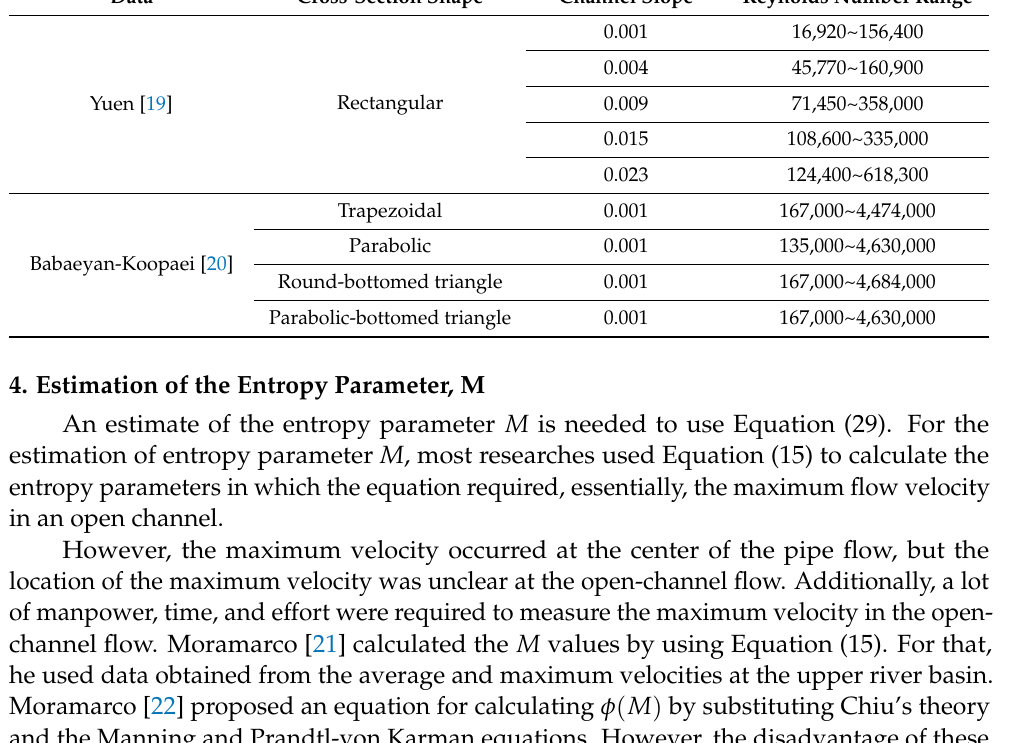
Figure 4. Relationship between (cid:1839) and (cid:1844)(cid:1857) calculated using Babaeyan-Koopaei’s data. 5. Results Analysis The entropy parameter M, defined in Section 4, was used in Equation (32) to calculate the coefficient of friction (cid:1858) in an open-channel flow. The relationship between (cid:1858) and (cid:1844)(cid:1857) is shown in Figures 5 and 6.